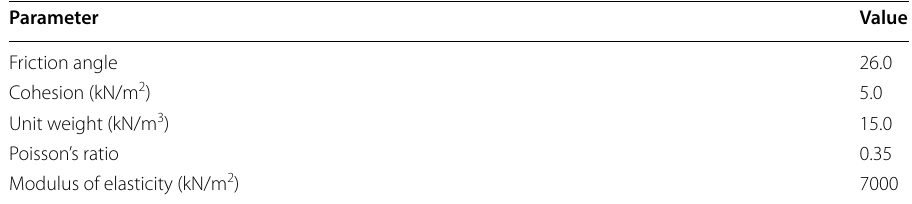
Table 3 Clay properties for numerical modeling Parameter